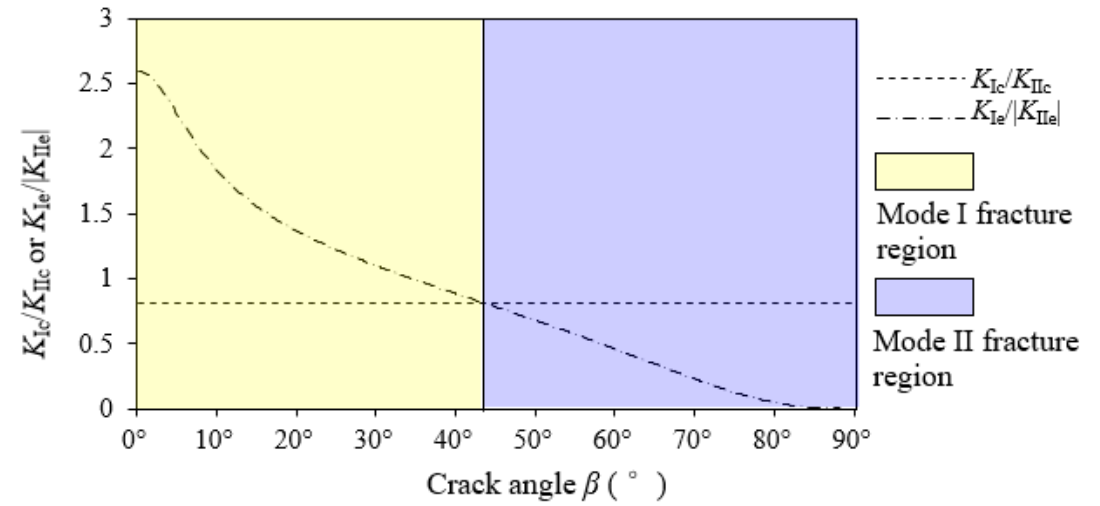
Figure 10. Mode-I and mode-II fracture regions for hollow cracks.